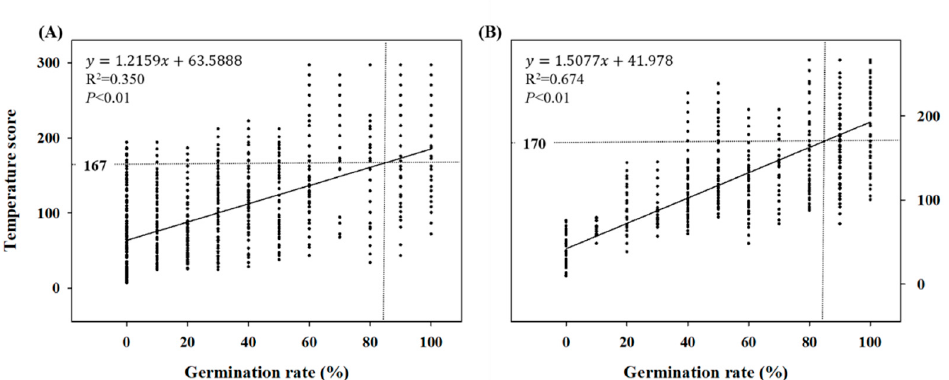
Figure 3. Linear regression analysis between daily temperature score (TS) and germination percent- age of Agastache rugosa ( A ) and Astilbe rubra ( B ). TS is the accumulated value of the daily temperature data according to the equation in Table 2. Temperature requirement is cumulative TS at 85% germination ( n = 300).